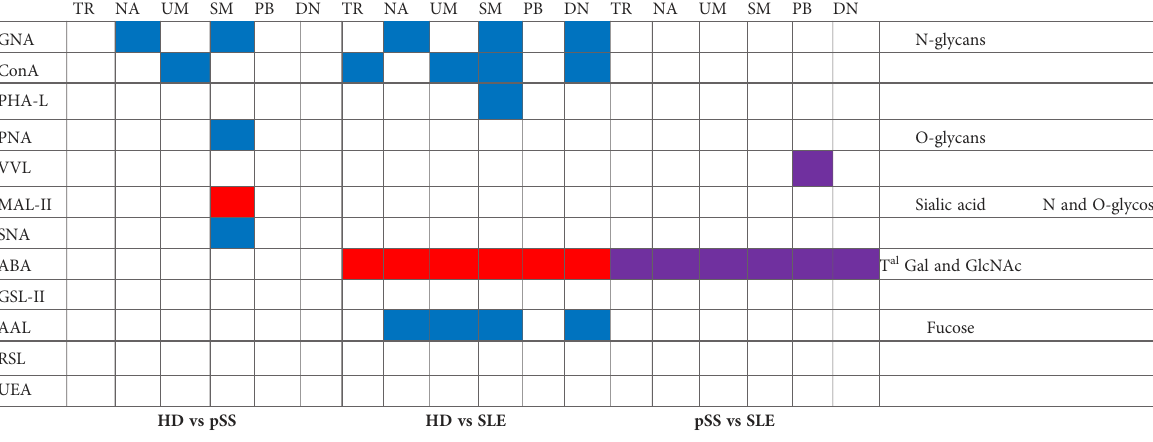
TABLE 5 Schematic representation of the glycopro fi le obtained for each B cell subsets presented in the Supplementary Figure